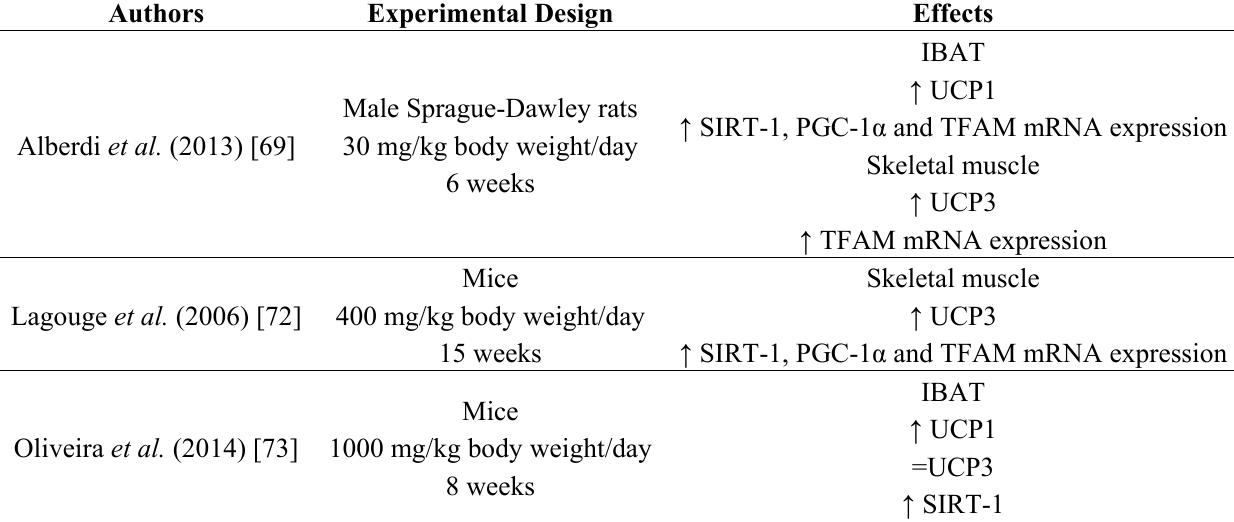
Table 5. Effects of resveratrol on thermogenesis in in vivo